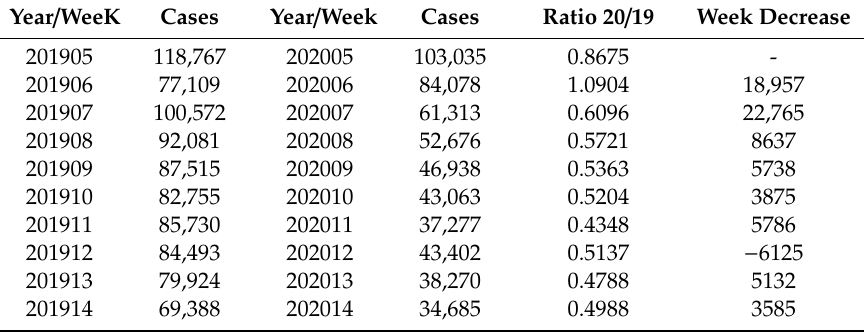
Table 1. Taiwan influenza-like illness 2020 cases during mass masking and 2019 comparison, data extracted and analyzed from Taiwan CDC